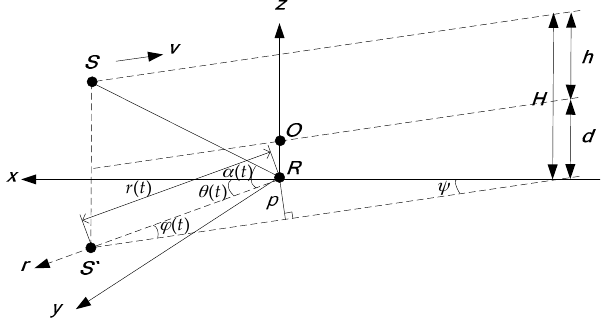
Figure 4. The passive localization geometry schematic diagram.